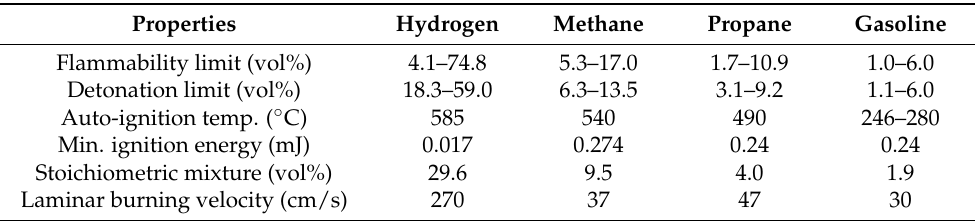
Table 5. Comparison of combustion properties among fuels at atmospheric condition (temperature and pressure of 25 °C and 1 atm, respectively) [18,120].